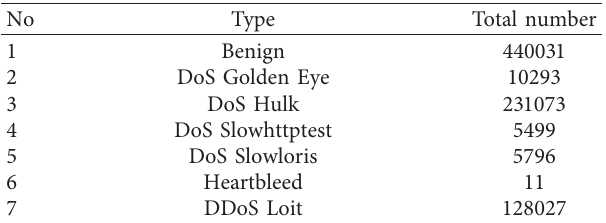
Table 1: Total number of DoS/DDoS attacks in CICIDS2017